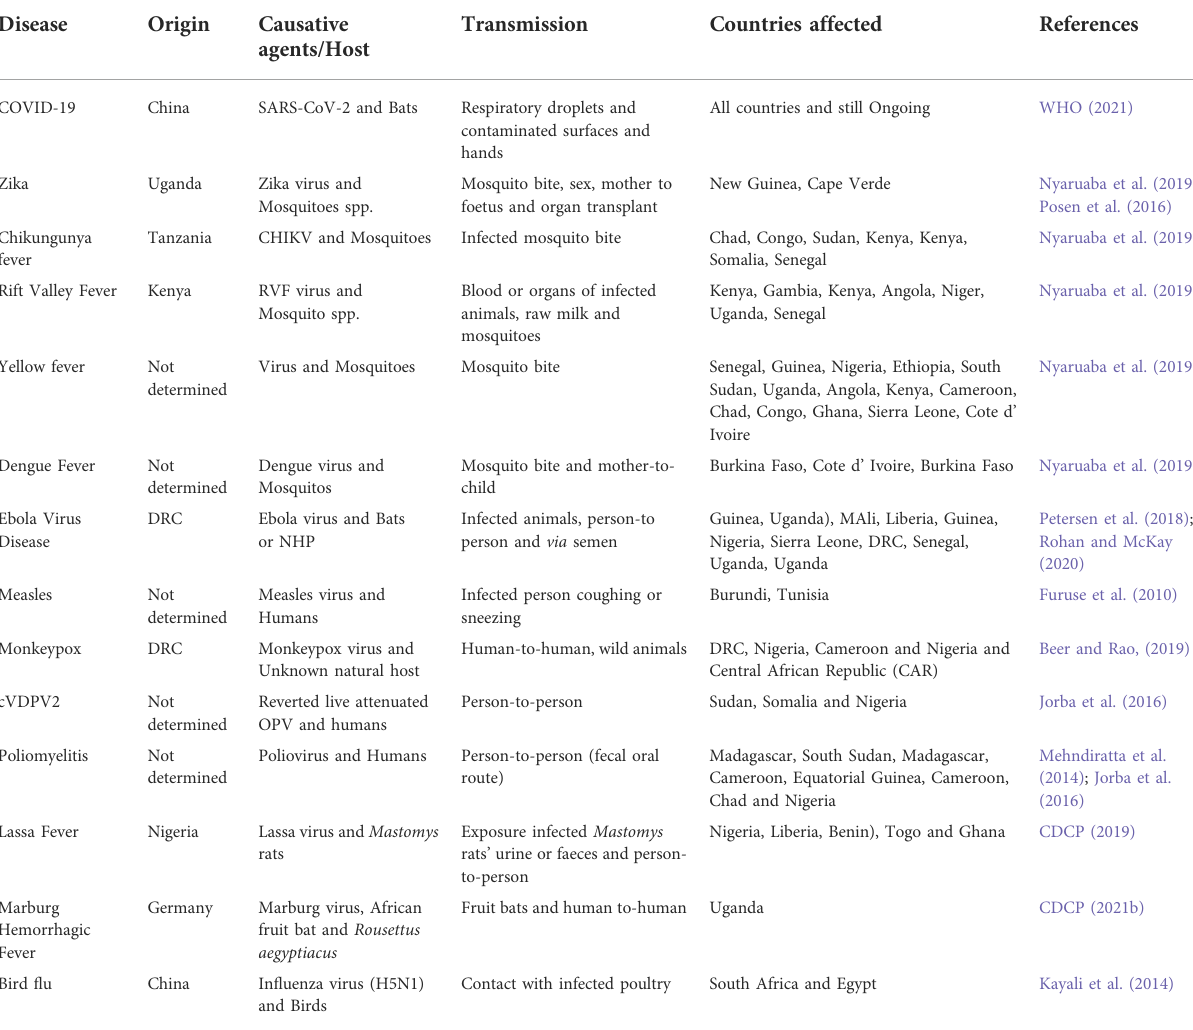
TABLE 1 Emerging Infectious Diseases in Africa in the past